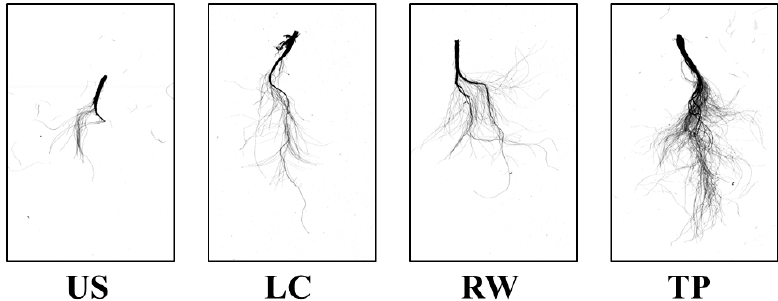
Figure 3. Root images of Adenophora triphylla var. japonica Hara seedlings as affected by different media at 54 days after transplanting. US, urethane sponges; LC, LC grow foam; RW, rockwool; and TP, terra-plugs.